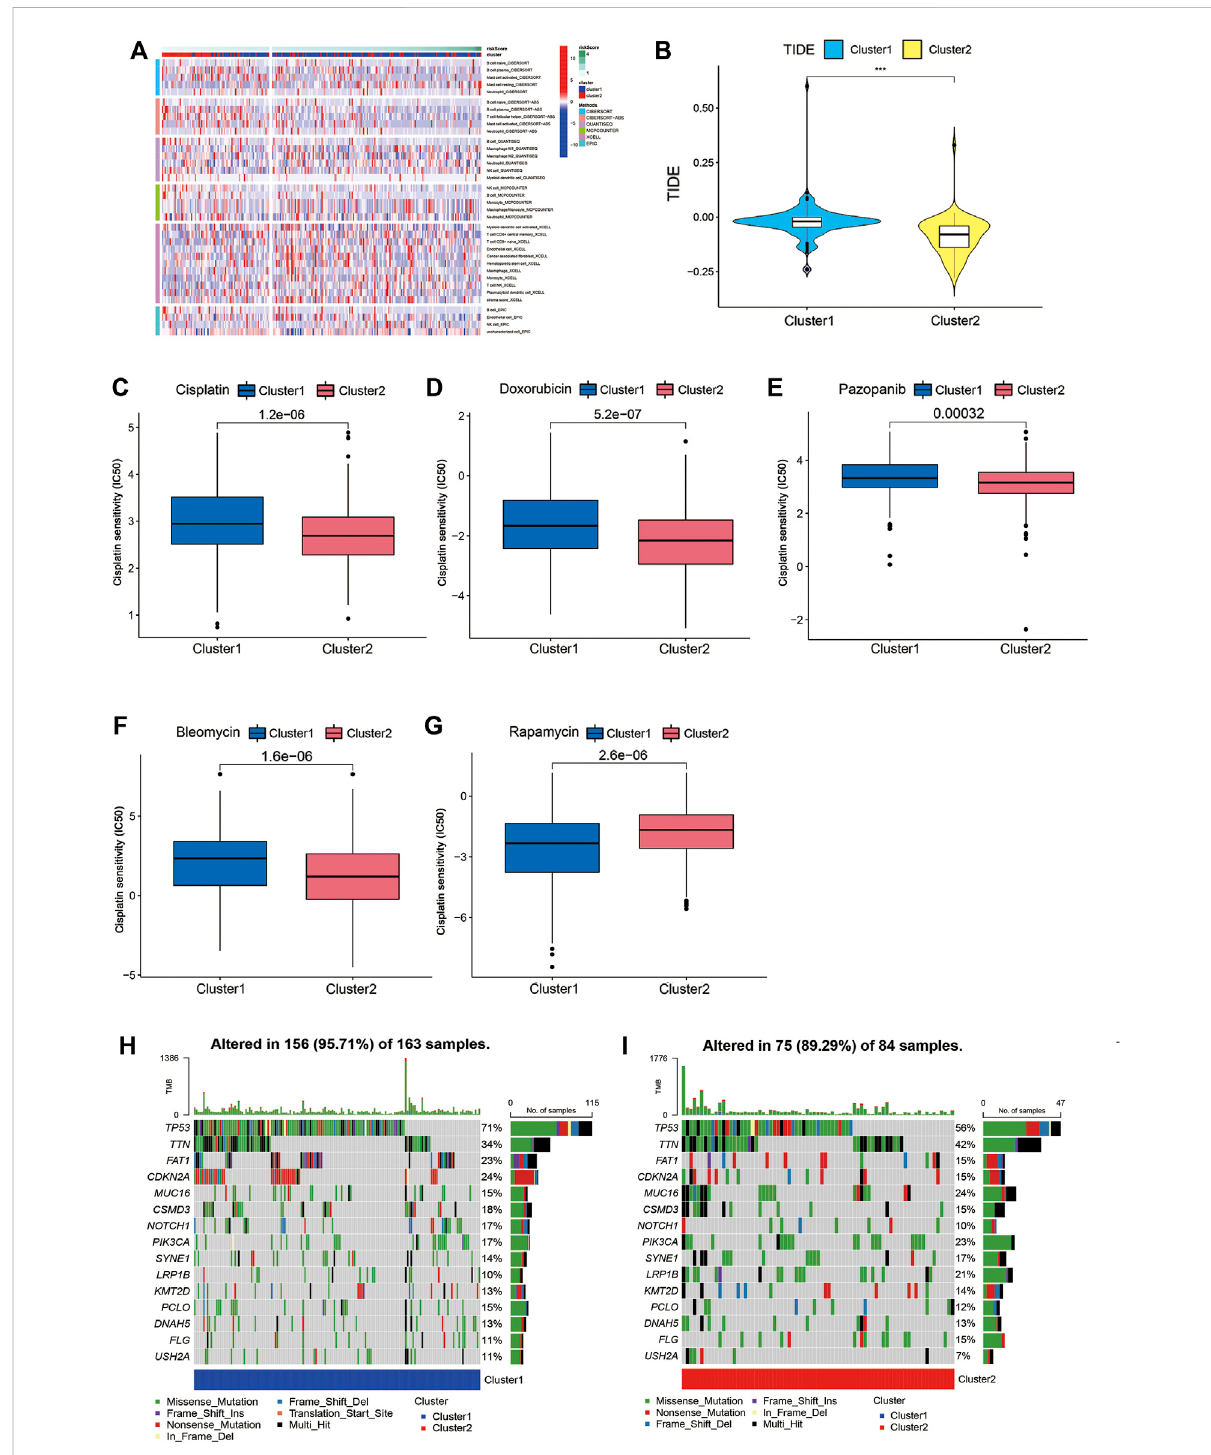
FIGURE 10 GSVA,TIDE,drugsensitivityandSNPalternation. (A) Theimmunein fi ltrationbasedondifferentalgorithms. (B) TIDEscorebetweenCluster1and Cluster2. Comparisons of the IC50 values between the two clusters for Cisplatin (C) , Doxorubicin (D) , Bleomycin (E) , Pazopanib (F) and Rapamycin (G) . (H,I) SNP alterations were identi fi ed in Cluster1 and Cluster2. * p < 0.05, ** p < 0.01, *** p <